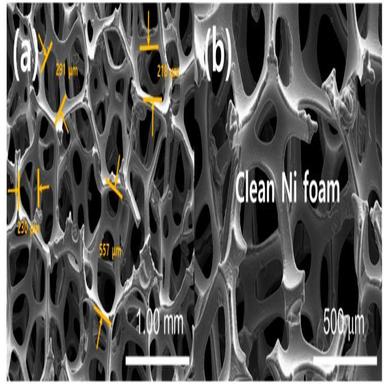
(a) Low-magnification SEM image; (b) high-magnification SEM image of clean Ni foam as substrate.